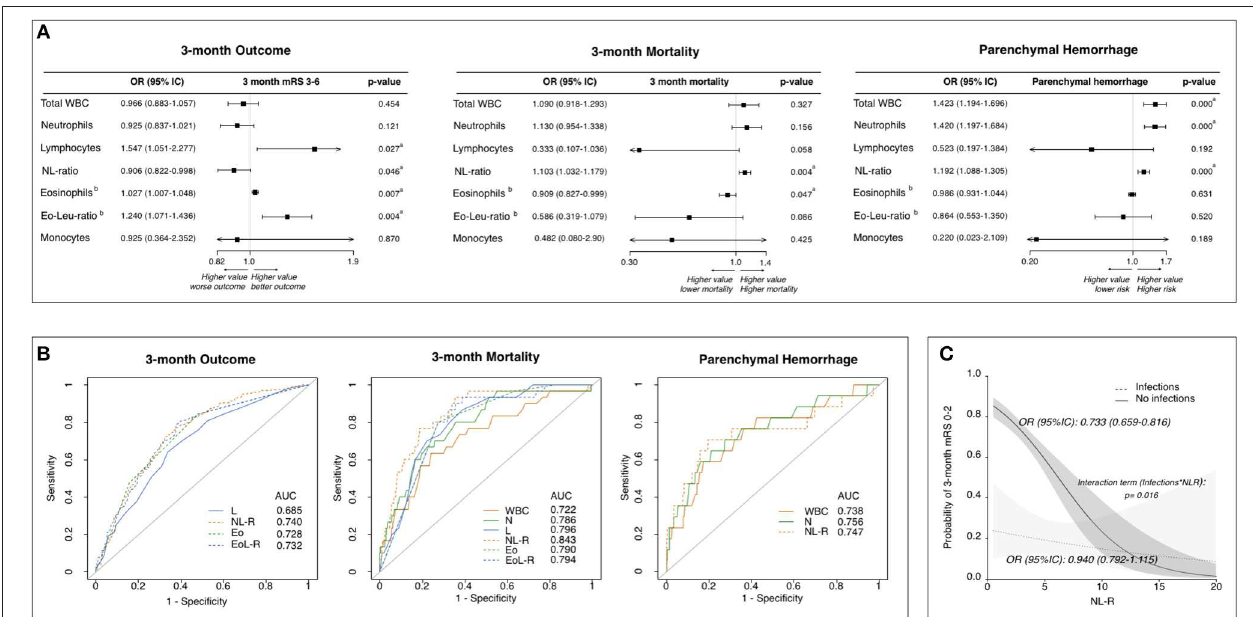
FIGURE 1 | Leukocyte counts and ratios at stroke admission are predictive of stroke outcome independently of infections. (A) Adjusted association of leukocyte subtype counts/ratios with outcome measures. Forest plots showing leukocyte subtypes associated to 3-month functional outcome, to 3-month mortality and to parenchymal hemorrhagic transformation (Multivariate analysis). Statistics: Logistic Regression analysis. Data were adjusted for parameters resulted to be associated in the univariate analysis ( Supplementary Table I ) with p ≤ 0.10 (including post-stroke infections). Each leukocyte subtype count/ratio was entered in a separate model as independent variable (detailed in Supplementary Table II ). a Significant ( p ≤ 0.05). b OR is intended for 0.01-point increase of Eosinophil count and EoLeu-R. (B) Predictive values of leukocyte subtype counts/ratios for outcome measures. Receiver operating characteristic curves for the 3-month functional outcome, 3-month mortality and parenchymal hemorrhage. (C) Relationship between NL-R and stroke outcome according to post-stroke infections. Probability of good functional outcome according to NL-R in patients with (dashed line) and without (continuous line) early post-stroke infection as predicted by logistic regression model containing as independent variables: NL-R as continuous variable, early post-stroke infections as categorical dummy variable, time from stroke onset to blood sample and an interaction term between post-stroke infection and NL-R. AUC, area under curve, WBC, white blood cells; N, neutrophils; L, lymphocytes, NL-R, neutrophil to lymphocyte ratio; Eo, eosinophils; Eo-Leu-R, eosinophil to leukocyte